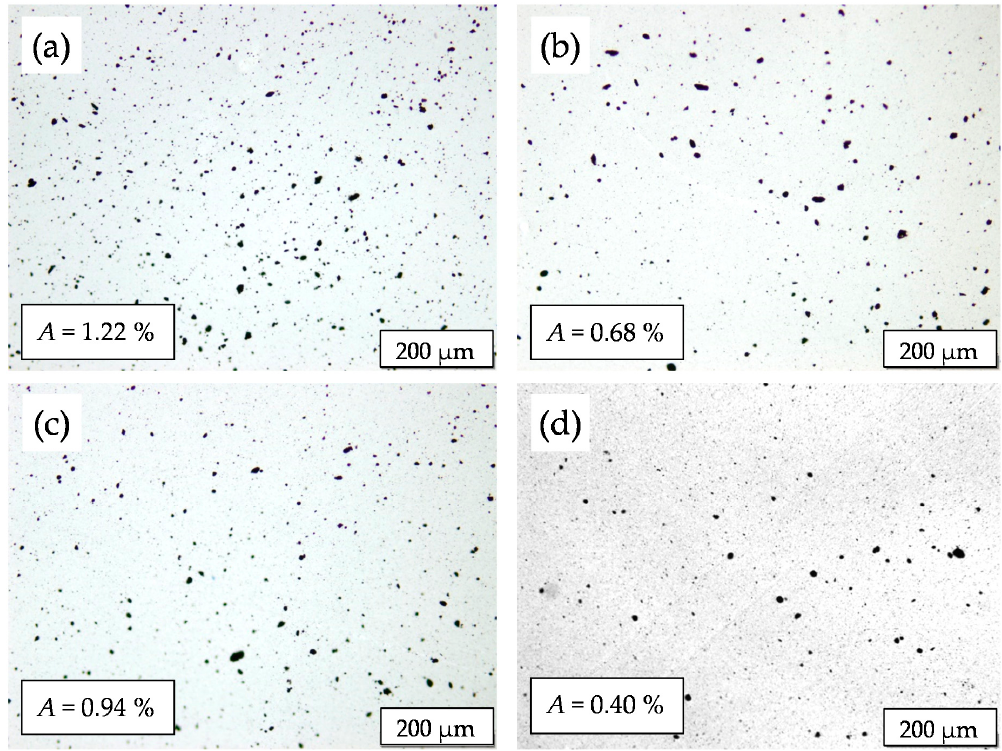
Figure 2. Transmission light microscopy (TLM) images and agglomerate area ratio ( A ) of melt mixed LN3/MWCNT composites with 1 wt% MWCNTs at varying processing conditions: ( a ) A: 180 °C, 100 rpm, ( b ) B: 180 °C, 200 rpm, ( c ) C: 200 °C, 100 rpm, and ( d ) D: 200 °C, 200 rpm .